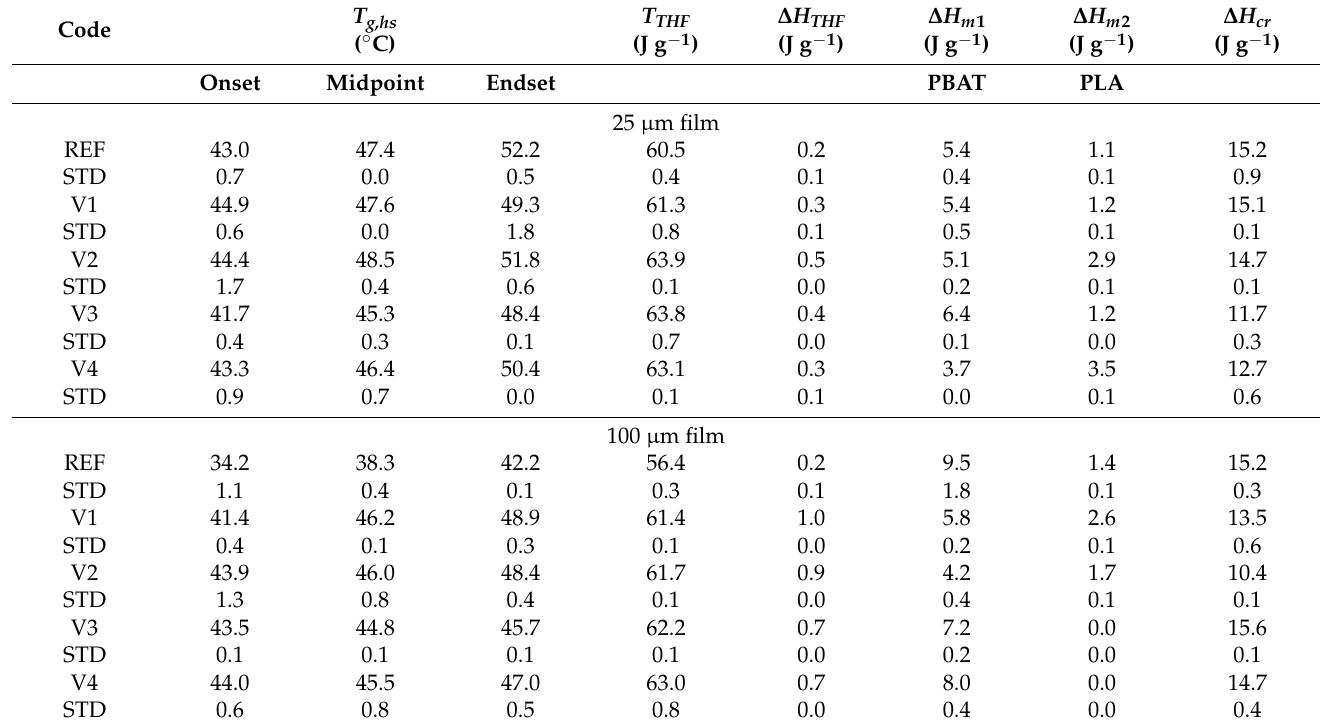
Table 4. The glass temperatures of hard segments T g,hs , THF boiling temperature T THF , THF boiling enthalpy ∆ H THF , and fusion heats ∆ H m 1 (PLA) and ∆ H m 2 (PBAT) as determined by the first run and crystallization enthalpy ∆ H cr of 25 µ m and 100 µ m films of REF and V1 to V4